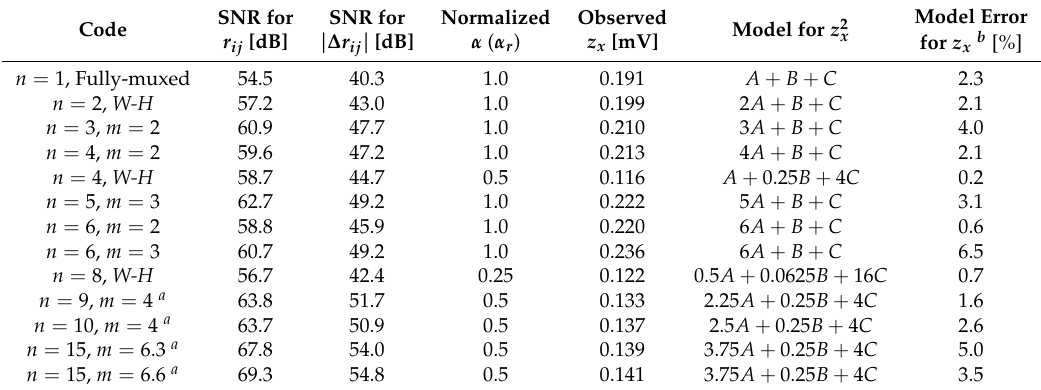
Observed SNRs for r ij and | ∆ r ij | in W-H s [1,10,12–14] and proposed M-H s where α V TX (cid:39) 101